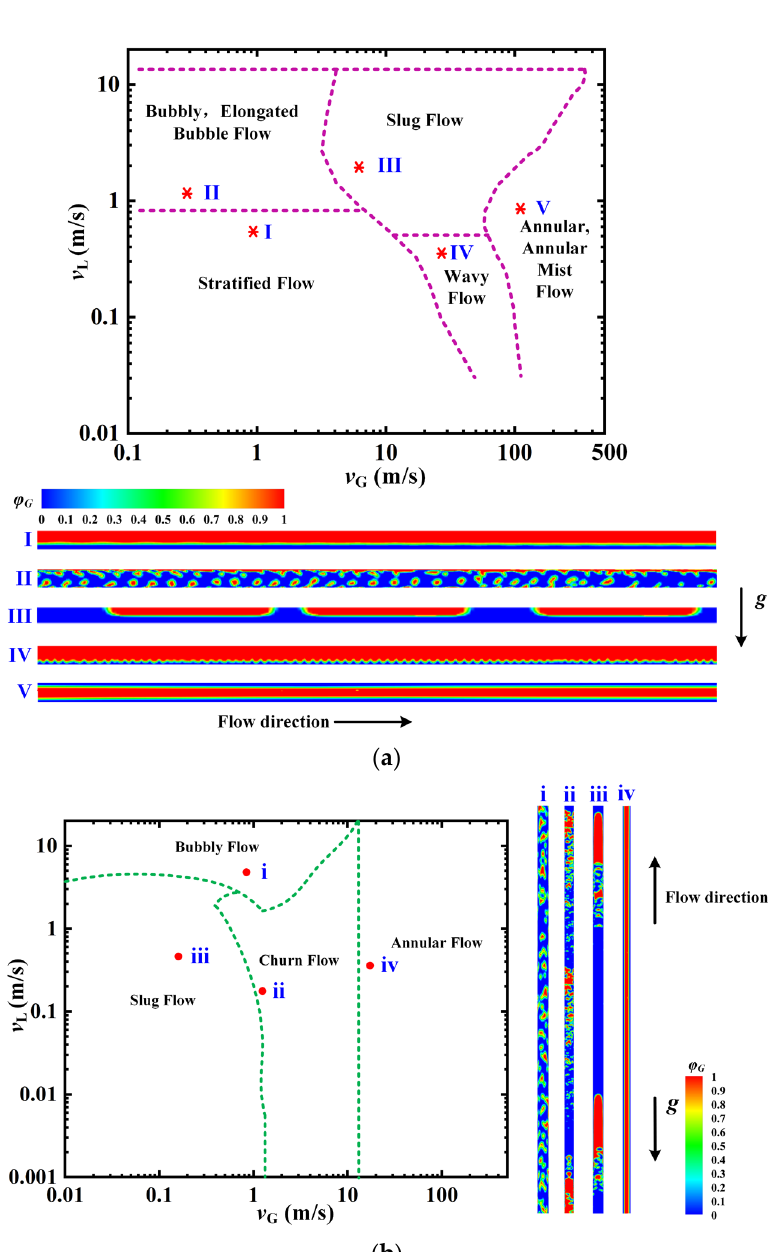
Figure 5. Model validation for the production of gas–liquid two-phase flow regimes in both horizontal and vertical tubes against the reported flow pattern maps, where v G and v L are the gas and liquid superficial velocities, respectively: ( a ) flow regimes in a horizontal tube [7], where the red stars denote the simulated cases; ( b ) flow regimes in a vertical tube [8], where the red circles denote the simulated